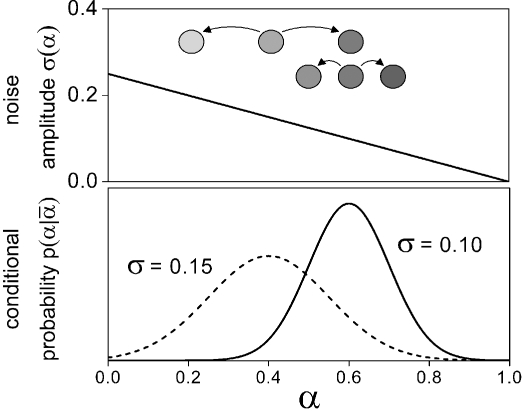
Multiplicative noise-driven dynamics.Upper panel: state-specific noise amplitude (standard deviation) σ(α) of the Gaussian conditional probability density function (cpdf)  assumed to be a linear decreasing function of α. The pictogram shows a cell with α = 0.4 being scattered towards α = 0.2 and 0.6, respectively (upper row). The subsequent scatter starting at α = 0.6 has a smaller range (lower row). This results in an average rightward drift of the peak position of the probability distribution of α-values P(α) (see also Methods). Lower panel: Gaussian cpdf  as a function of α for  (left) and  (right). The corresponding standard deviations are σ(0.4) = 0.15 and σ(0.6) = 0.10.